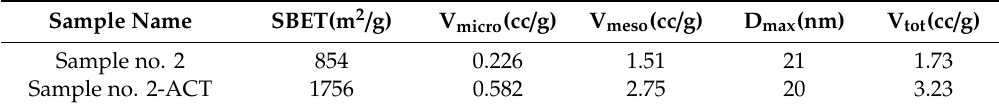
Table 3. BET values of the optimised carbon xerogels before and after activation.